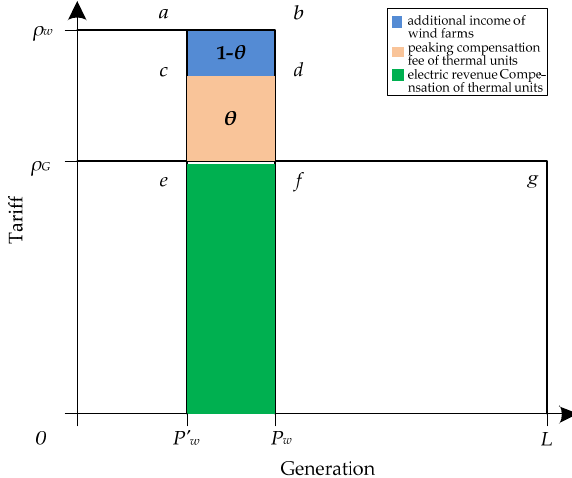
Figure 2. The allocation of system additional income.